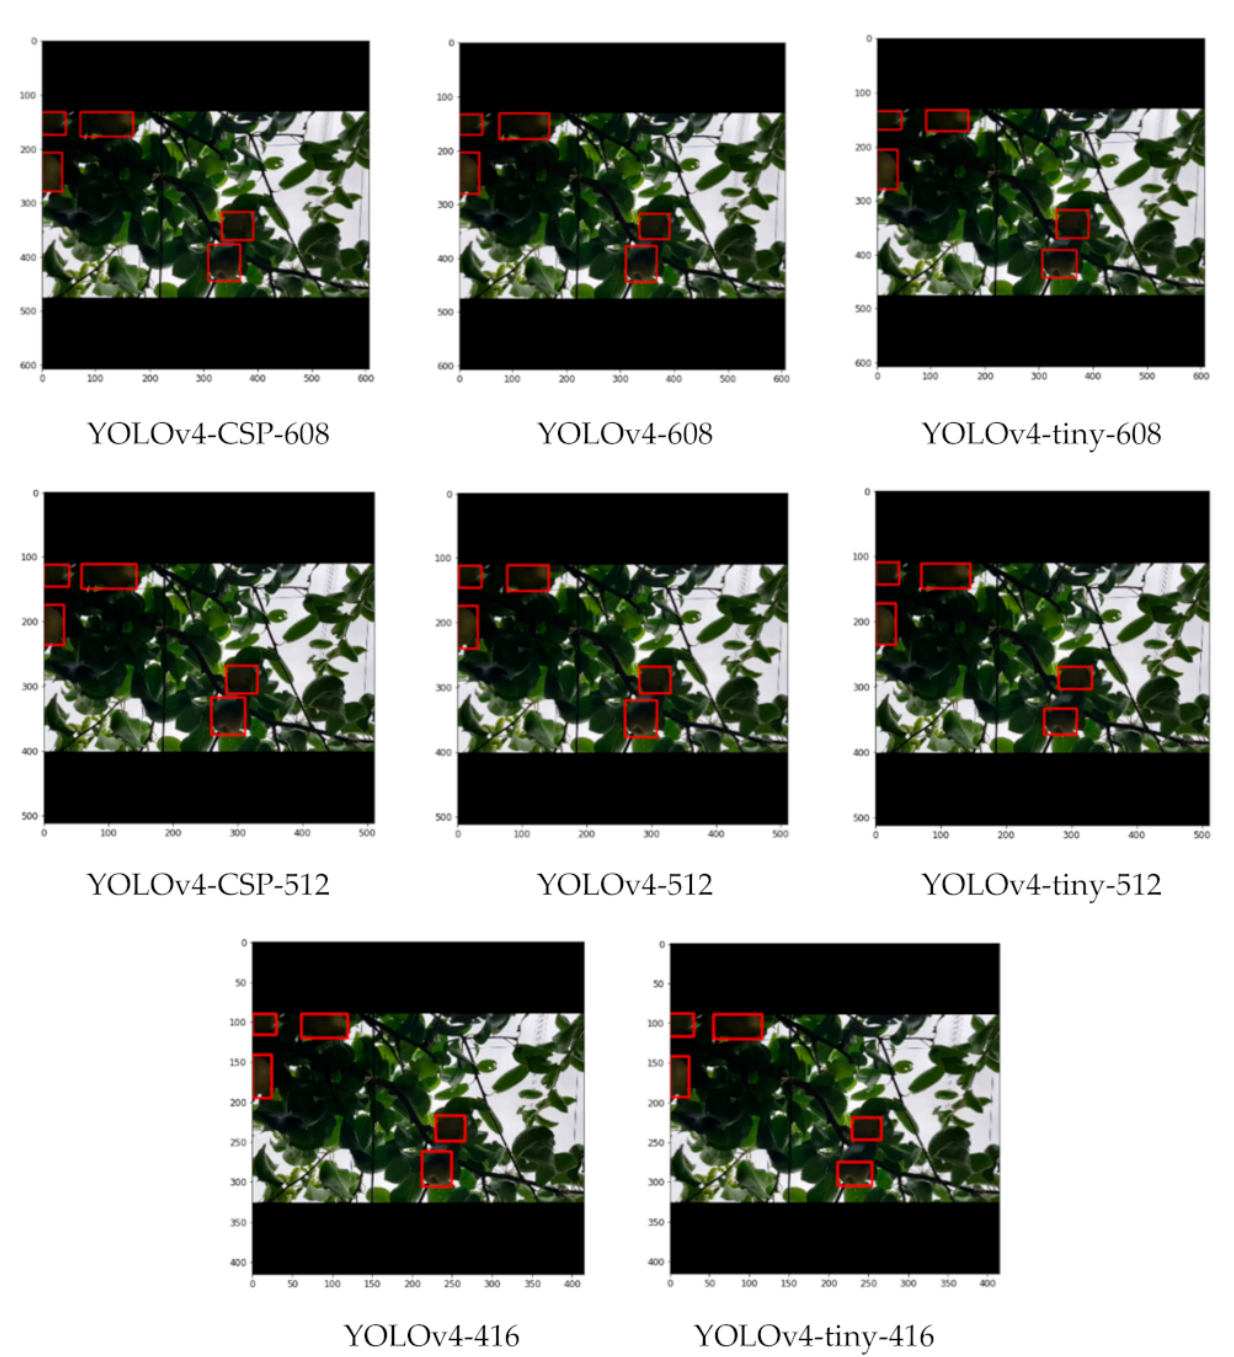
Figure 19. Example detections from the different YOLOv4 models using an image with slight occlusion, potentially- challenging illumination and considerable density of